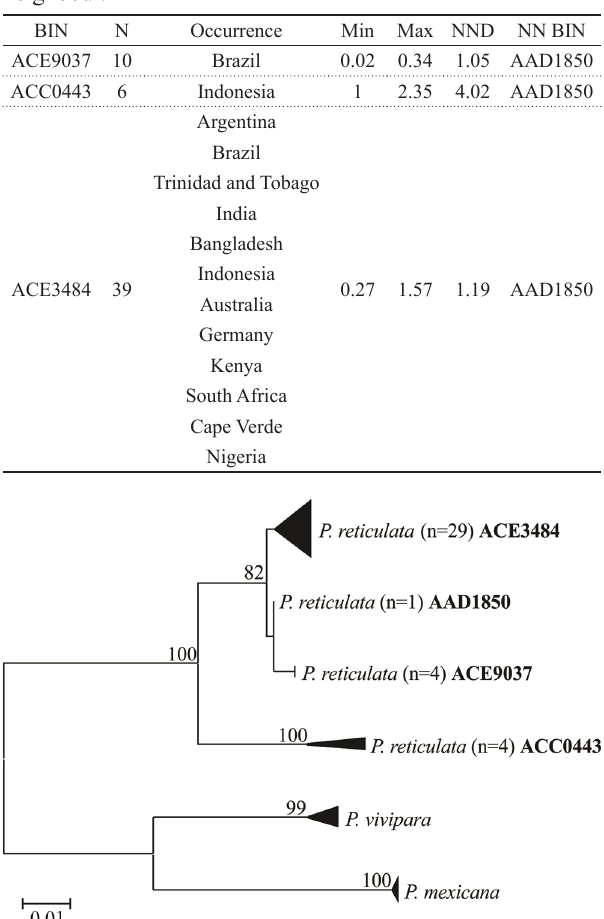
Tab. 2. Geographic location and distance summary of public BIN for Poecilia reticulata . N: number of specimens; Min: minimum genetic distance whithin BIN; Max: maximum genetic distance whithin BIN; NND: nearest neighbour distance and NND BIN: Barcode Index Number of the nearest neighbour.